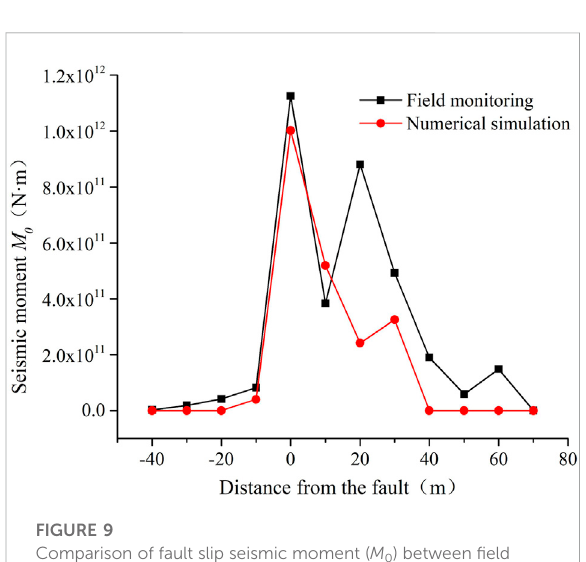
value calculated by numerical simulation. The mining situation and fault stress state of the working face in the process of the numerical simulation were consistent with the actual situation on site. The fault